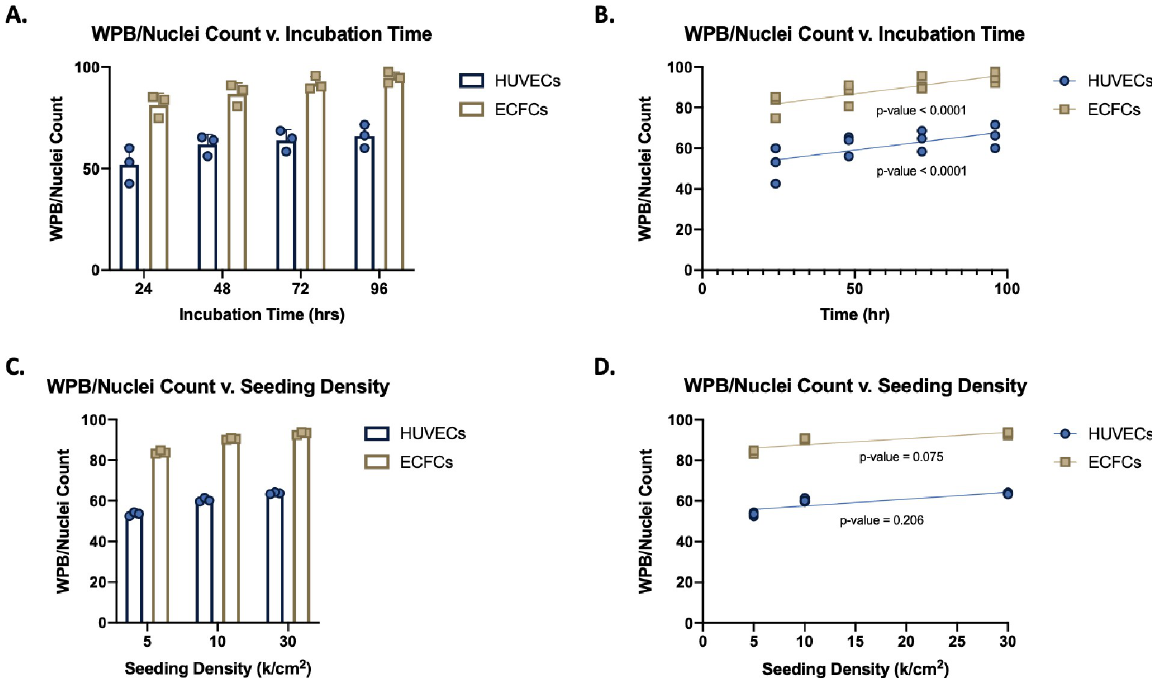
Fig 2. Effect of incubation time and seeding density on WPB/Nuclei count for HUVECs and ECFCs. (A) Evaluation of WPB/Nuclei count for both HUVECs and ECFCs in response to increasing incubation time (24, 48, 72, and 96 hrs.) with a constant seeding density of 30,000 cells/cm 2 (n = 3). (B) The linear regression analysis of WPB/Nuclei count for a constant seeding density. (C) WPB/Nuclei count is evaluated in response to varying seeding densities (5,000, 10,000, and 30,000 cells/cm 2 ) at a constant incubation time of 96 hrs. (n = 3). (D) The linear regression analysis of WPB/Nuclei count for a constant incubation